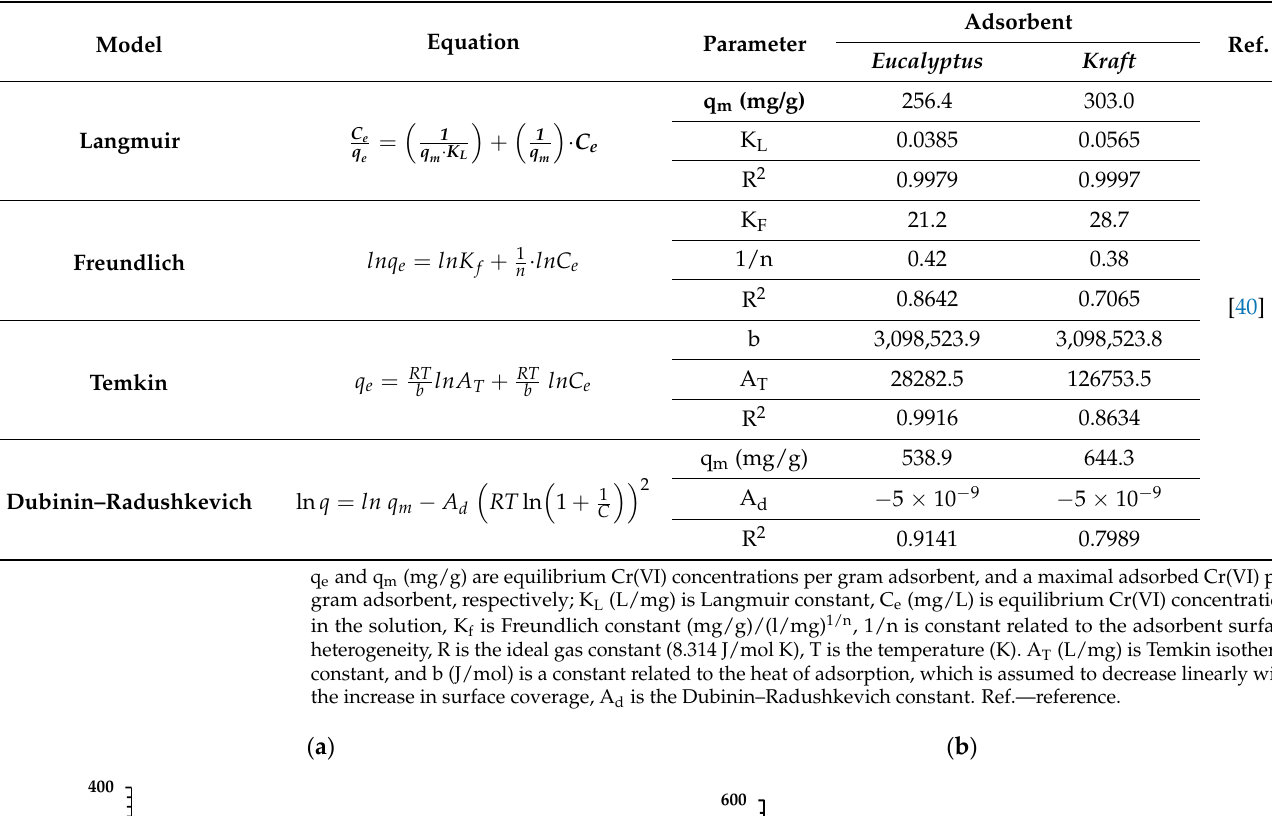
Table 4. Isotherm models and corresponding parameters for chromium ions adsorption onto eucalypt stump lignin and kraft lignin.